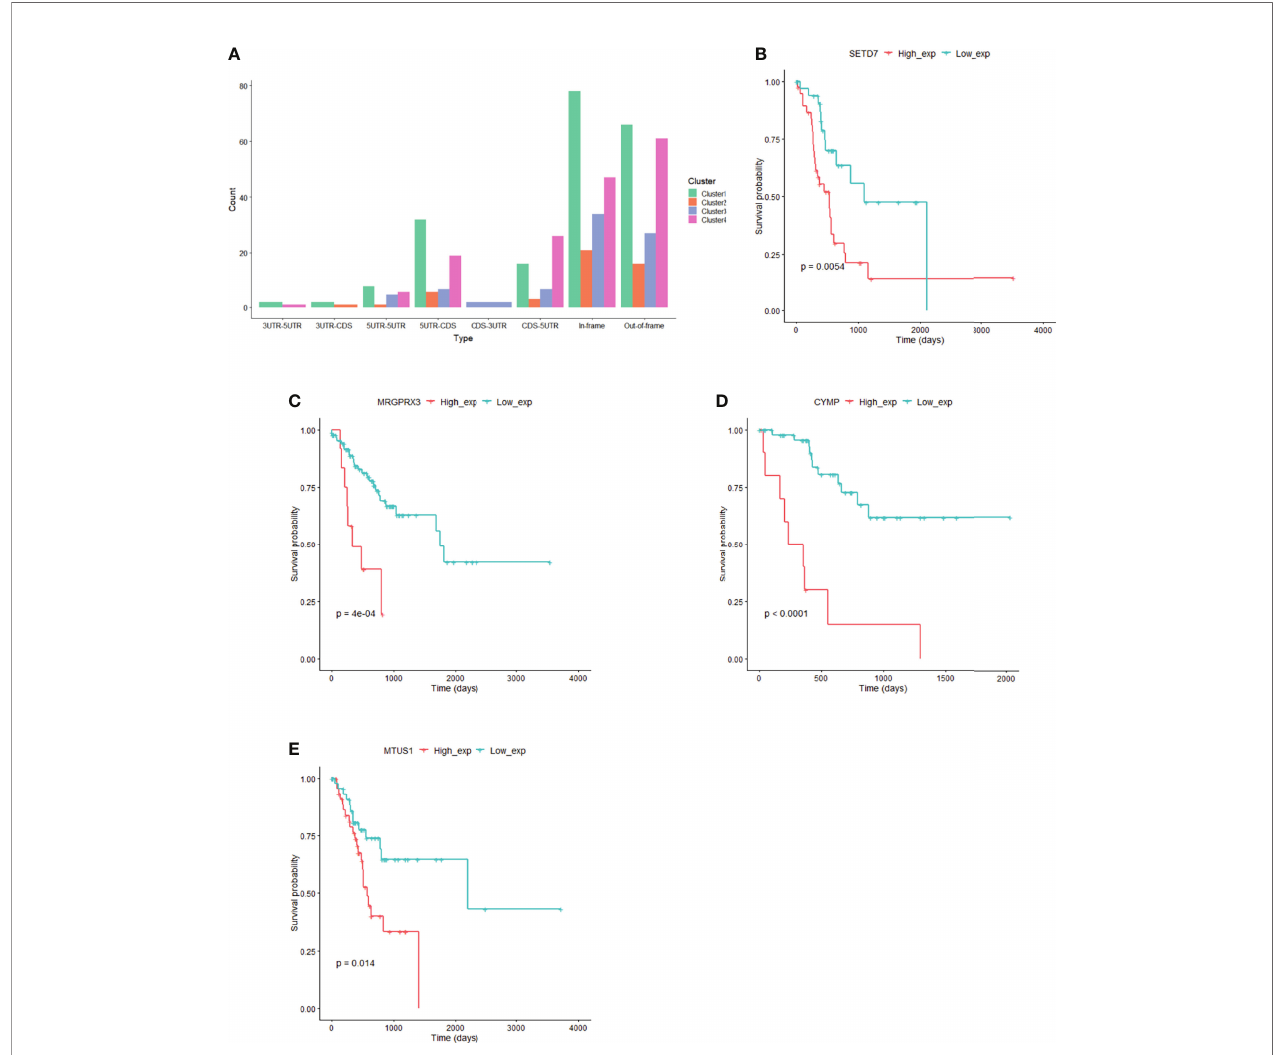
FIGURE 6 | Fusion gene and prognostic markers in subgroups. (A) Fusion gene characteristics in subgroup. (B) SETD7 gene expression correlated with prognosis in cluster1. (C) MRGPRX3 gene expression correlated with prognosis in cluster2. (D) CYMP gene expression correlated with prognosis in cluster3. (E) MTUS1 gene expression correlated with prognosis in